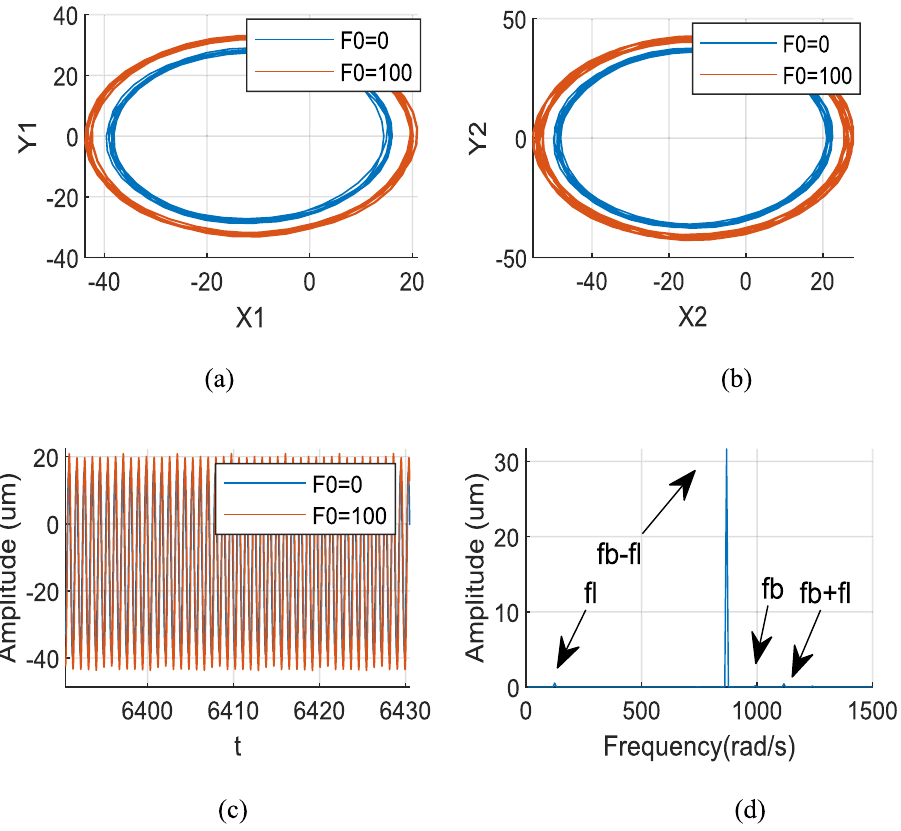
Figure 12. Aerodynamic resonance A of LP rotor (λ = 1. 75, ω l = 124 rad/s) ( a ) Orbit diagram of LP rotor ( b ) Orbit diagram of HP rotor ( c ) Time history ( d ) Frequency